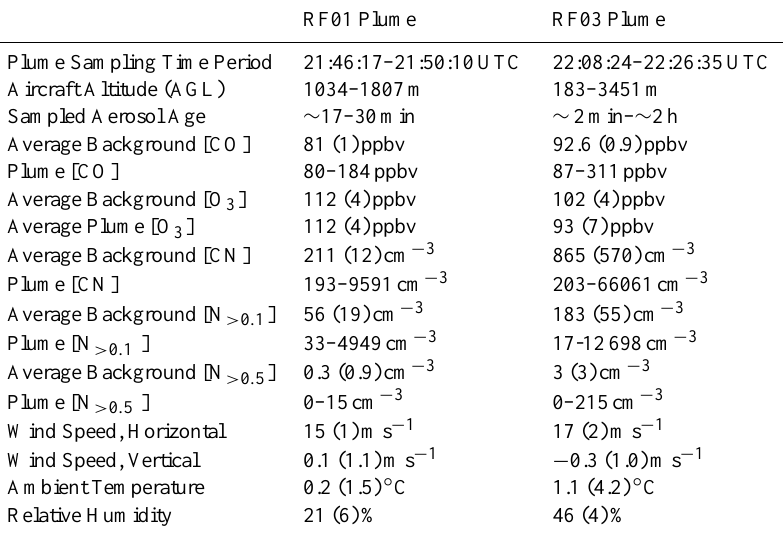
Table 2. C-130 aircraft sampling time periods and altitudes for the RF01 and RF03 smoke plumes, as well as the estimated aerosol age, based on C-130 location and wind speed data. For carbon monoxide (CO), ozone (O 3 ), total condensation nuclei (CN), particles > 0.1µm (N > 0 . 1 ), and particles > 0.5µm (N > 0 . 5 ), average background concentrations (with standard deviations in parentheses) are shown along with the range of concentrations observed in the plume. Average horizontal and vertical wind speed, ambient temperature, and relative humidity, measured aboard the C-130 aircraft are shown with standard